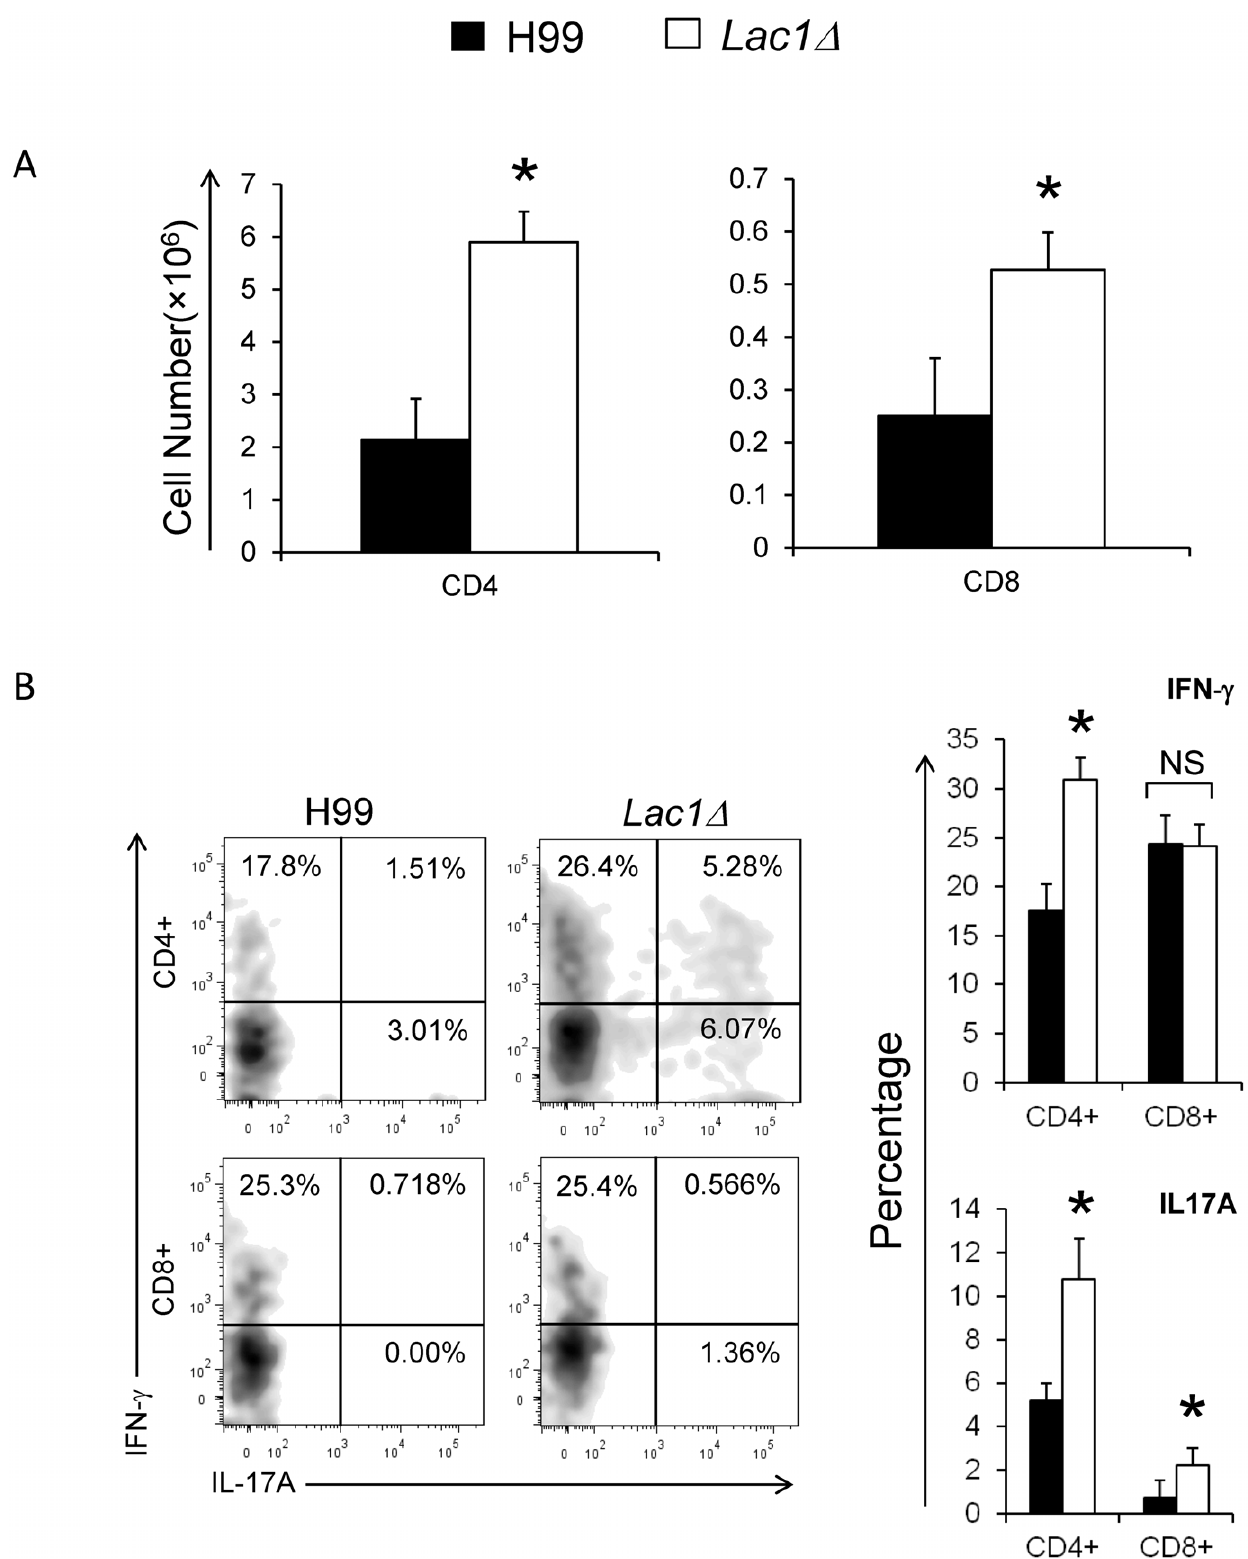
Figure 6. Effect of cryptococcal laccase on the recruitment and differentiation of CD4 + and CD8 + T-cells. Leukocytes were isolated from the lungs of mice infected with C. neoformans strain H99 or lac1 D at 3 wpi. The populations of CD4 + and CD8 + T lymphocytes were identified and enumerated using flow cytometry (A); Representative plots show intracellular IFN- c and IL-17A staining in the lung CD4 + and CD8 + T cells. The bar graphs presents the percentage of IFN- c and IL17A positive cells within lung CD4 + and CD8 + T cells (B). Bars represent data (mean 6 SEM) from 2